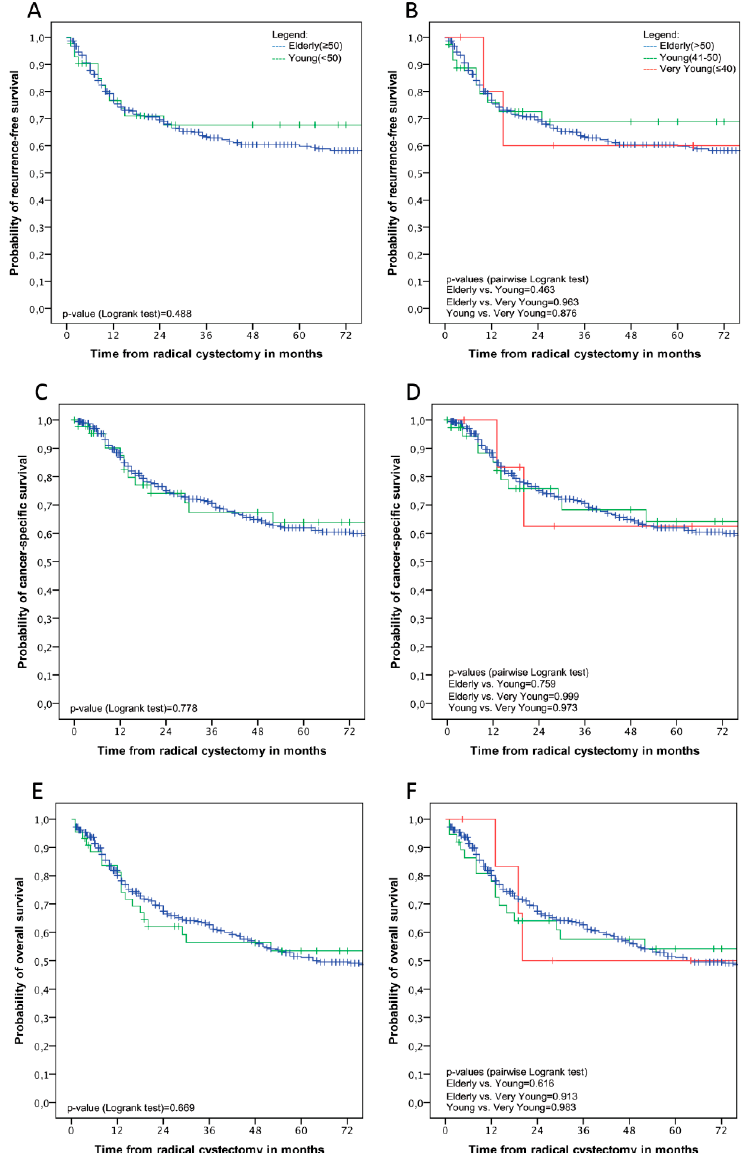
Figure 1. Kaplan–Meier estimates of stratified age groups of elderly ( ≥ 50 years.) and young patients ( < 50 years.) ( A , C , E ), and stratified in three age groups of elderly ( > 50 years.) young (41–50 years.) and very young ( ≤ 40 years.) patients ( B , D , F ) for recurrence-free, cancer-specific, and overall survival, respectively.